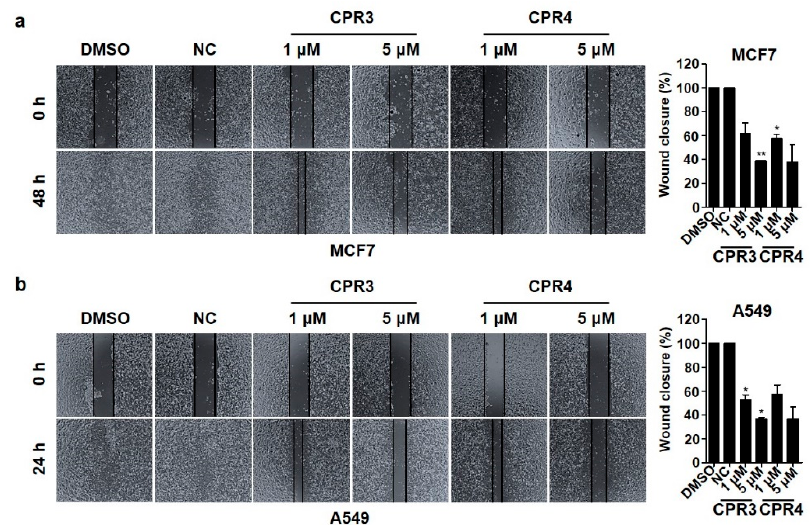
Figure 4. Wound healing images of MCF7 ( a ) and A549 ( b ) cells treated with CPR3 or CPR4 for 24 h. The PROTAC compound-treated cells were scratched with micropipette tip at 0 h. After 24 h, the migration status was monitored by bright optical microscopy. * P ≤ 0.05 and ** P ≤ 0.01, as determined by Student’s t-test.